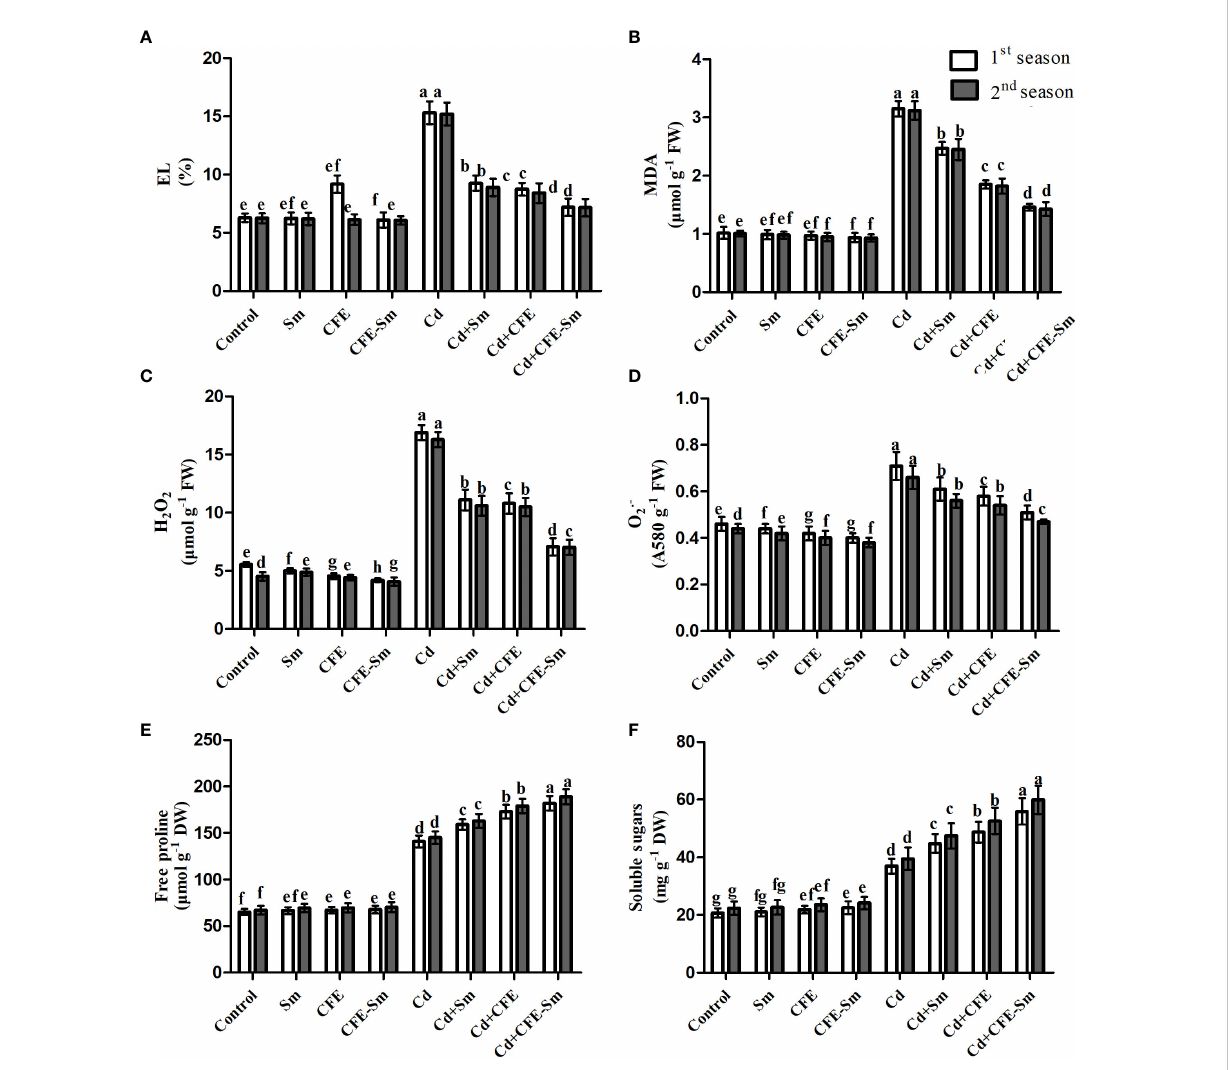
FIGURE 2 Impacts of silymarin (Sm), clove fruit extract (CFE), or silymarin-enriched clove fruit extract (CFE-Sm) foliar application on (A) Electrolyte leakage (EL), (B) malondialdehyde (MDA), (C) hydrogen peroxide (H 2 O 2 ), (D) superoxide radical (O (cid:129) − 2 ), (E) free proline and (F) soluble